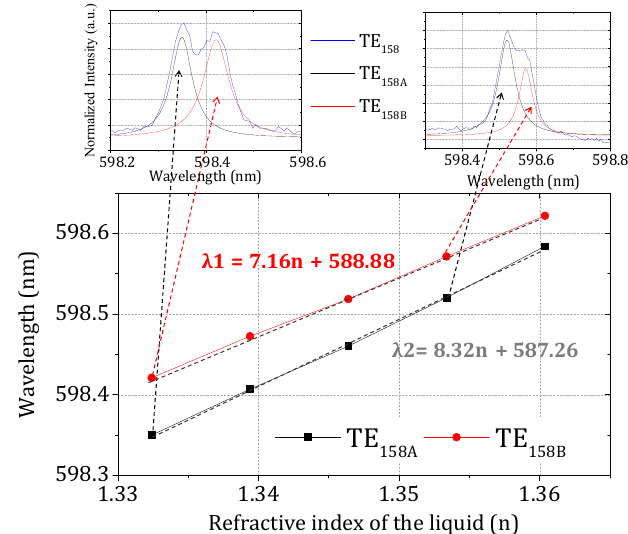
Figure 4. Measured resonance wavelengths as function of the surrounding RI for two sub-modes in TE 158 .